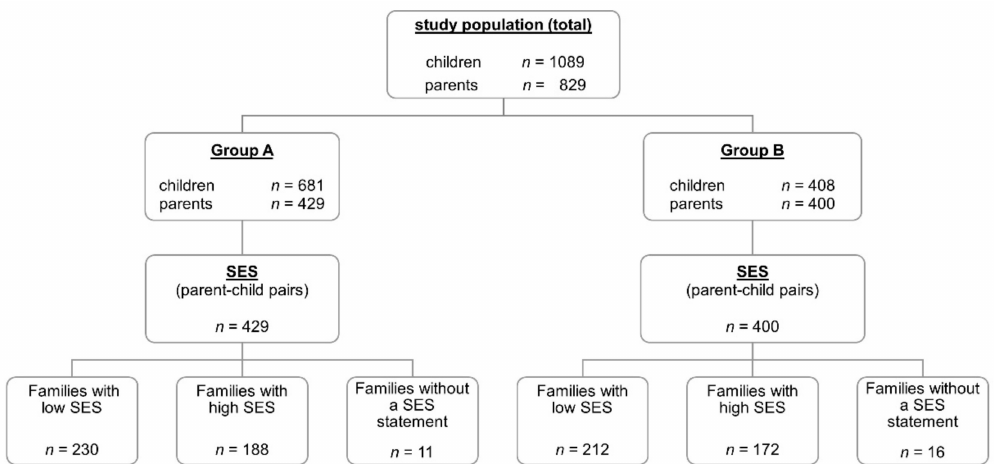
Figure 1. Overview of the study population (children and parents) and the distribution among the different subgroups (Group A—questionnaires with a fully completed diet section; Group B— questionnaires with incompletely completed diet sections; SES—socioeconomic